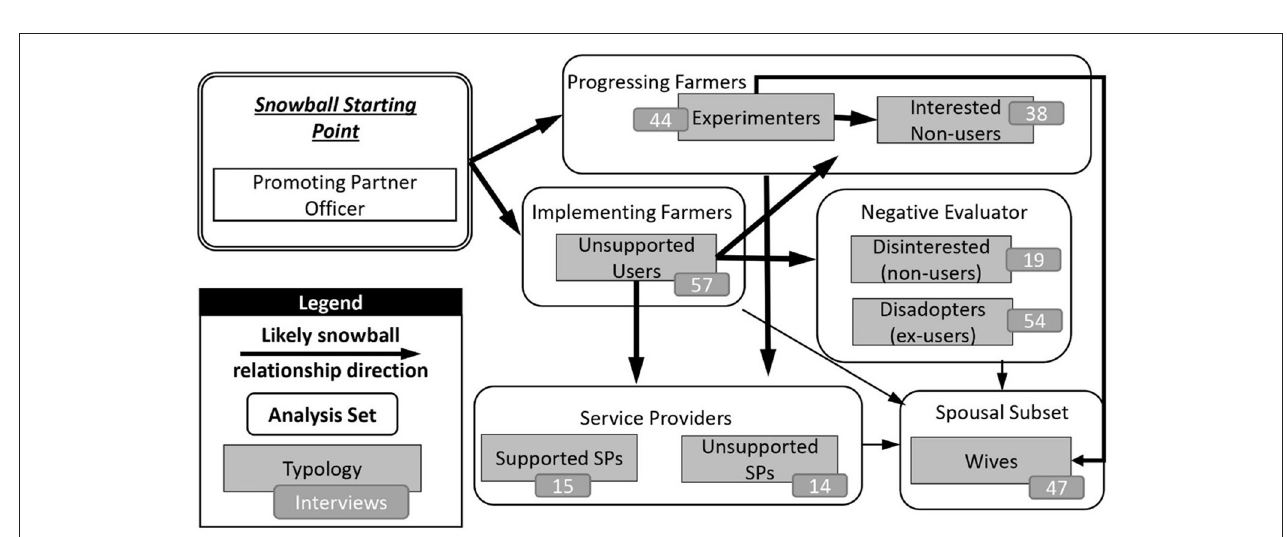
FIGURE 2 | Snowball sampling methodology employed in this study, with overall interviews shown across the total